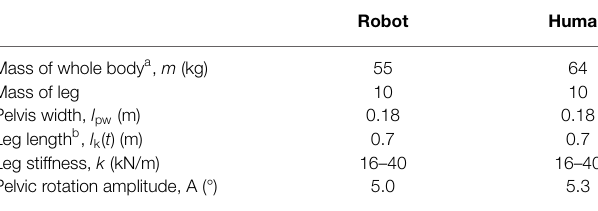
FIGURE 6 | Developed pelvis . Length are in mm. The pelvis had five joints; one pelvis roll joint, two hip pitch joints, two hip roll joints (A) . We chose 150-W DC motors, timing belts, and harmonic drives to actuate the pelvis and hip joints (B) . TABLE 2 | Configuration of the developed robot and human